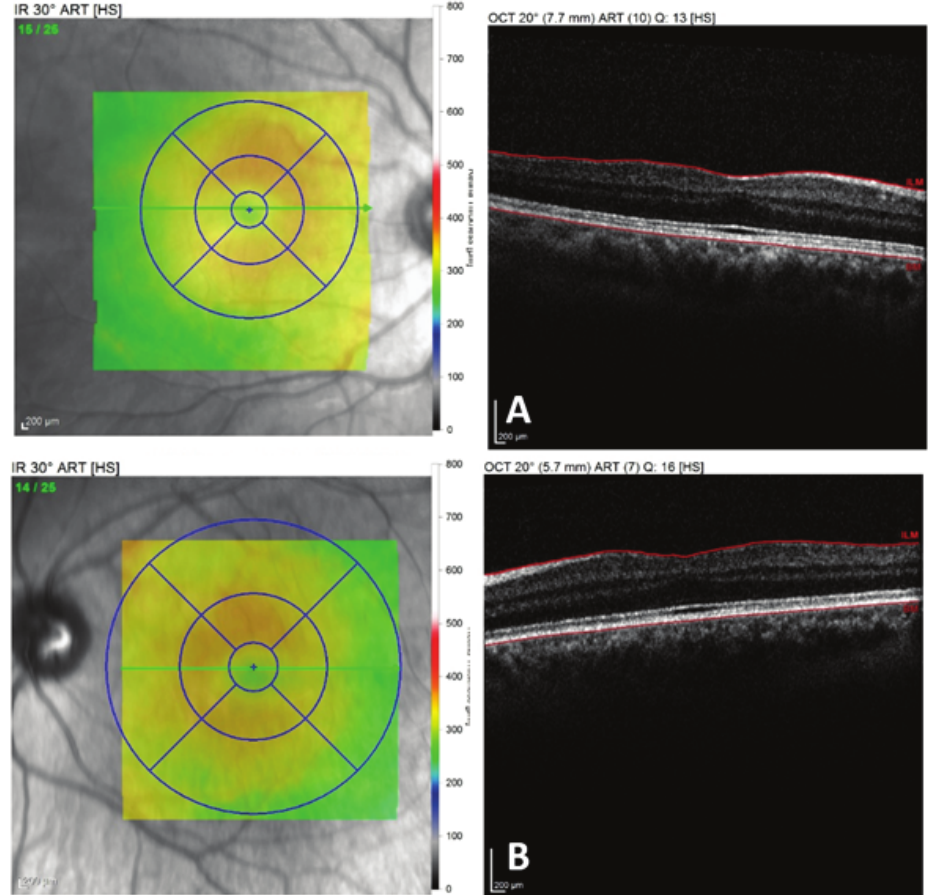
Figure 2. Spectral-domain optical coherence tomographic section through the center of the macular area of the right (A) and left (B) eyes. A shallow foveal pit, continuity of the inner retinal layers, the presence of outer nuclear layer (ONL) widening, and outer segment (OS) lengthening in the macula of both eyes are